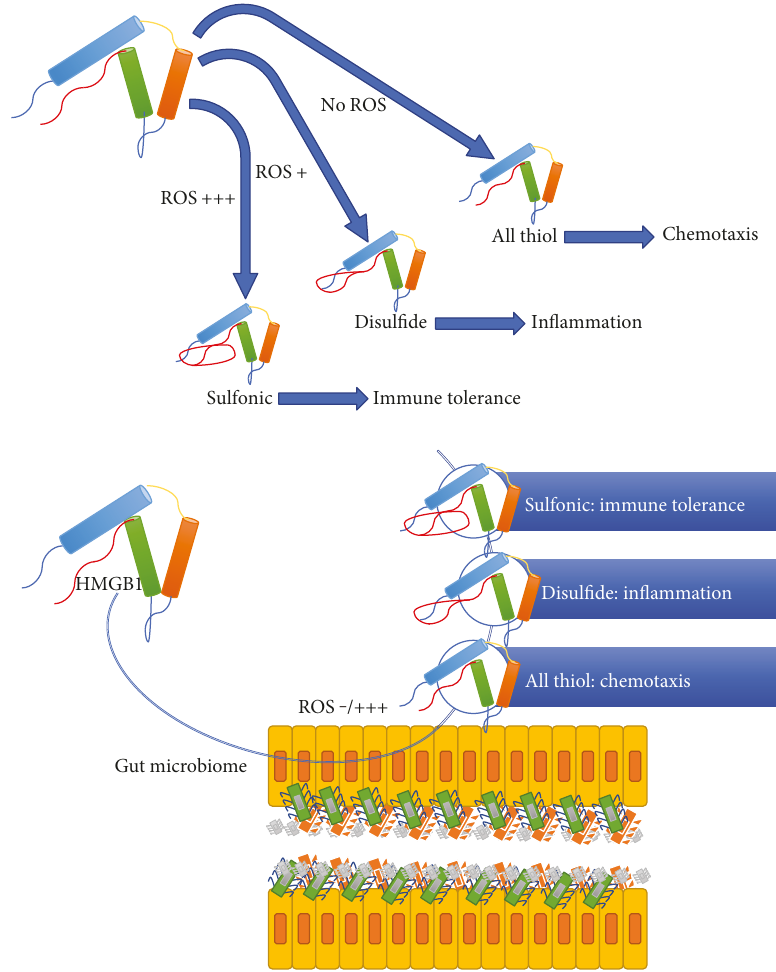
Figure 1: A schematic representation of the interaction and the crosstalk between HMGB1 and gut microbiome in RA pathogenesis. Depending on the oxidation/reduction status after the passage through the gut microbiome, HMGB1 can play several and di ff erent roles in RA initiation and